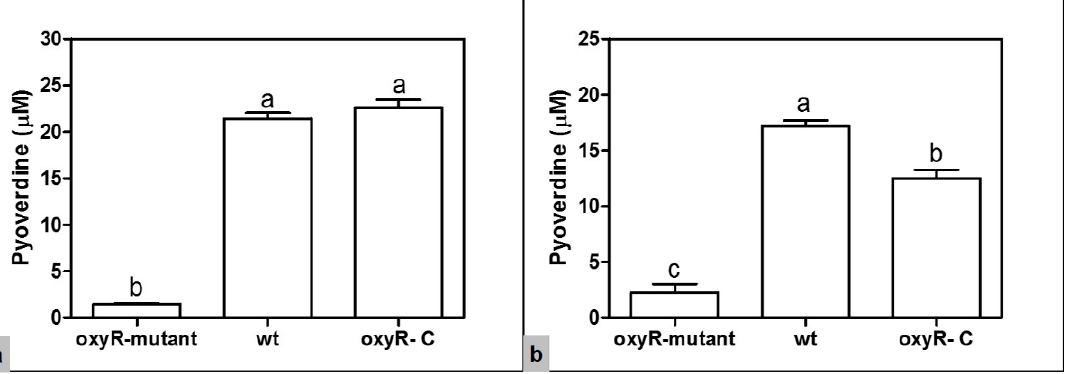
Figure 4. Pyoverdine production by the P. savastanoi pv. phaseolicola NPS3121 strains. ( a ) Pyoverdine levels in the cell free supernatants of the wt, oxyR-mutant , and oxyR- C strains, grown at 28 °C. ( b ) Pyoverdine levels in the cell free supernatants of the wt, oxyR-mutant , and oxyR- C strains, grown at 18 °C. Bars represent the means ± SD ( n = 3). Different letters represent means that are statistically different ( p < 0.05).